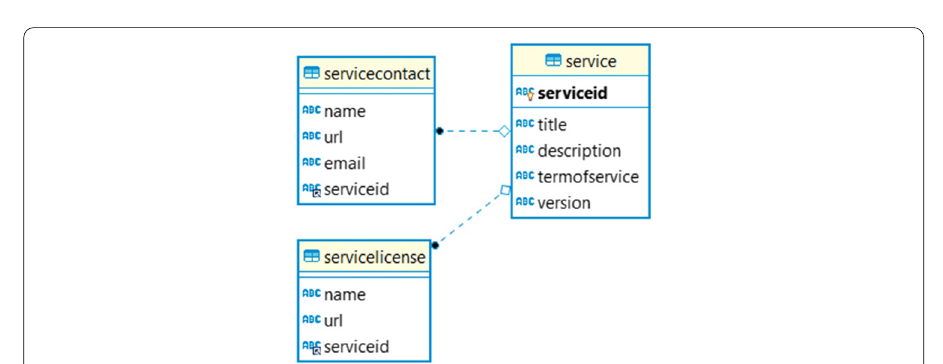
Fig. 3 Application of normalization techniques for info objects in